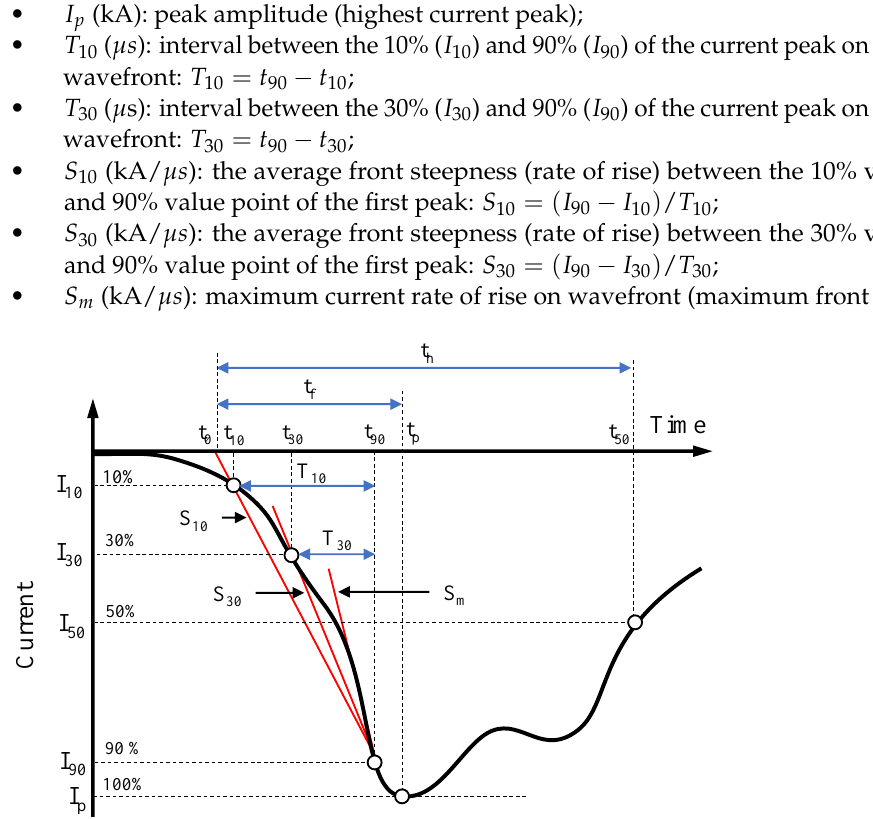
Figure 1. Typical lightning current waveshape and parameters, adapted from [22]. Based on the above parameters, the time duration of current front, t f , is defined as time interval from t 0 to t p and is determined as shown in Figure 1. The time to half